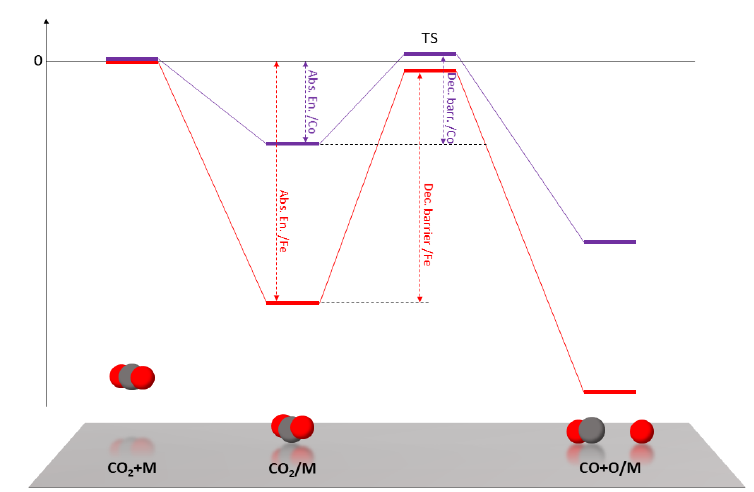
Figure 5. Schematic representation of the calculated energy levels of (from left to right) free CO 2 , adsorbed CO 2 , transition state, decomposed CO 2 into CO + O. In red, relative to Fe surface; in purple, relative to Co surface. The dashed vertical lines highlight the difference between Fe and Co in adsorption energy and decomposition barrier [29].